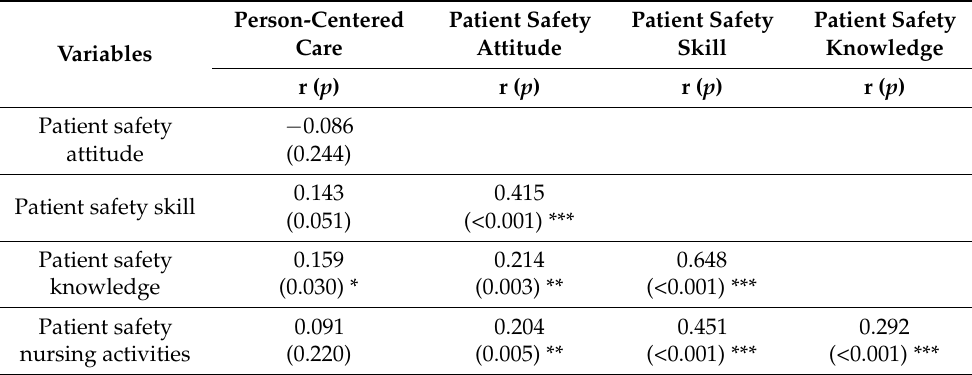
Table 4. Correlations between person-centered care, patient safety competence, and patient safety nursing activities. ( N = 186).